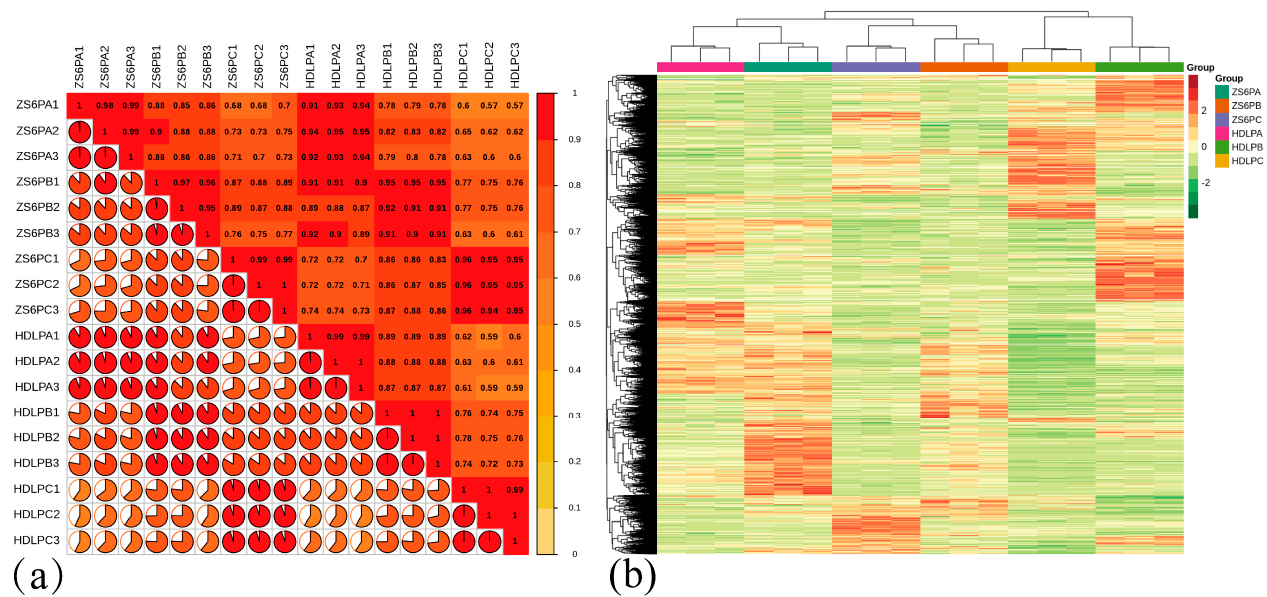
Figure 3. Basic transcriptome data analysis. ( a ) Heatmap of correlations between groups; ( b ) three- stage cluster heat map of all detected DEGs. Increased and decreased amounts of gene transcripts are shown by the colors red and green, respectively.